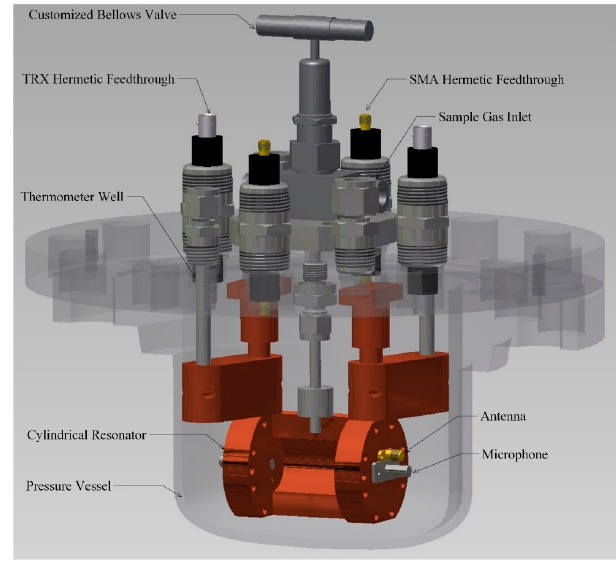
Figure 1. 3D overview of the cylindrical acoustic-microwave resonator.